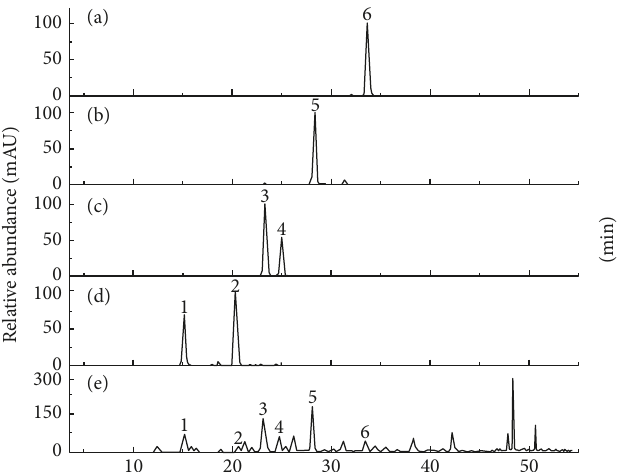
Figure 2: Chromatograms of LC and LC-MS for the identi fi cation of fl avonoids in lotus plumule from XT: (a) isorhamnetin-3- O -rutinoside (6); (b) luteolin-7- O -neohesperidoside (5); (c) hyperoside (3) and isoquercitrin (4); (d) schaftoside (1) and isoschaftoside (2); (e) 50% ethanol